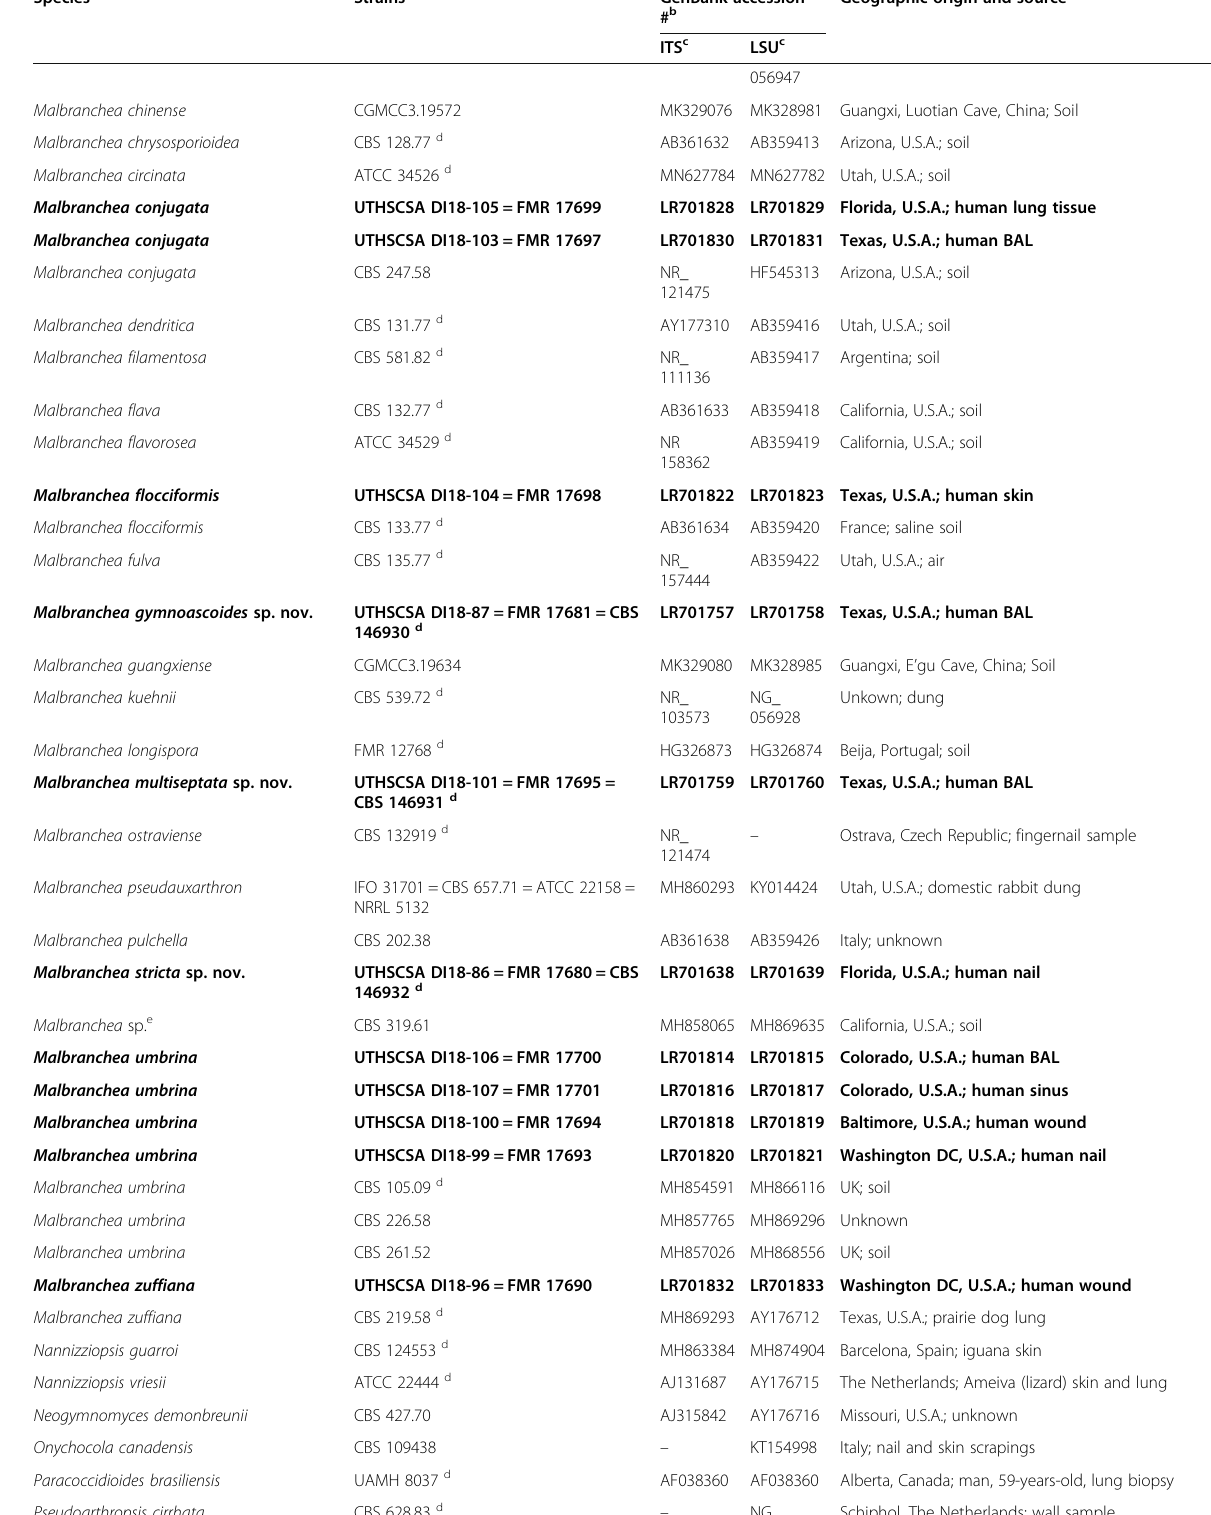
Table 1 DNA barcodes used to build the phylogenetic tree (Continued)